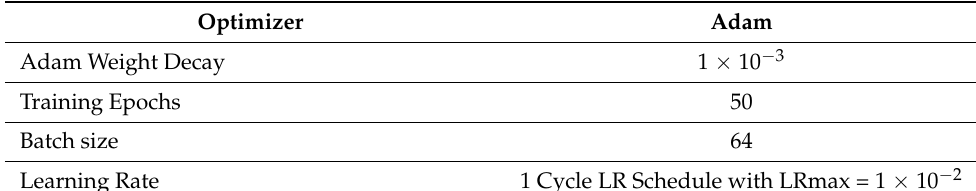
Table 1. Hyperparameters for the training phase of the model.